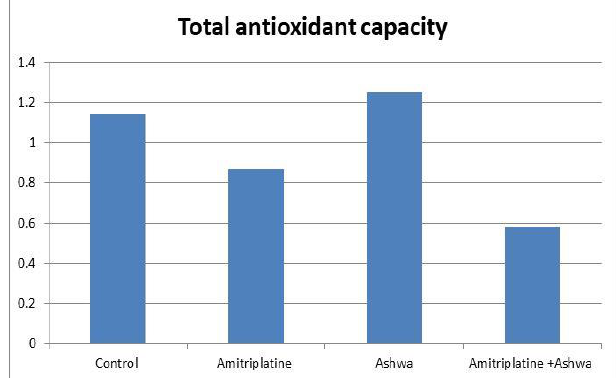
Fig.2:Serum total antioxidant capacity (U/L) at day 30 Acetylcholine esterase enzyme measurement in salivary glands